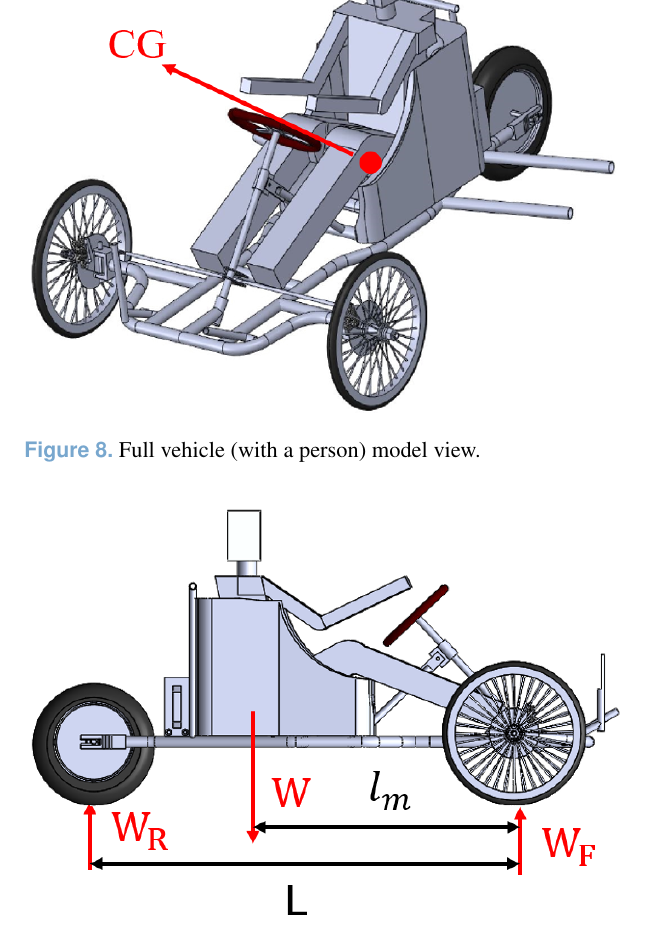
Figure 9. Schematic diagram of the front and rear wheel loads (static).